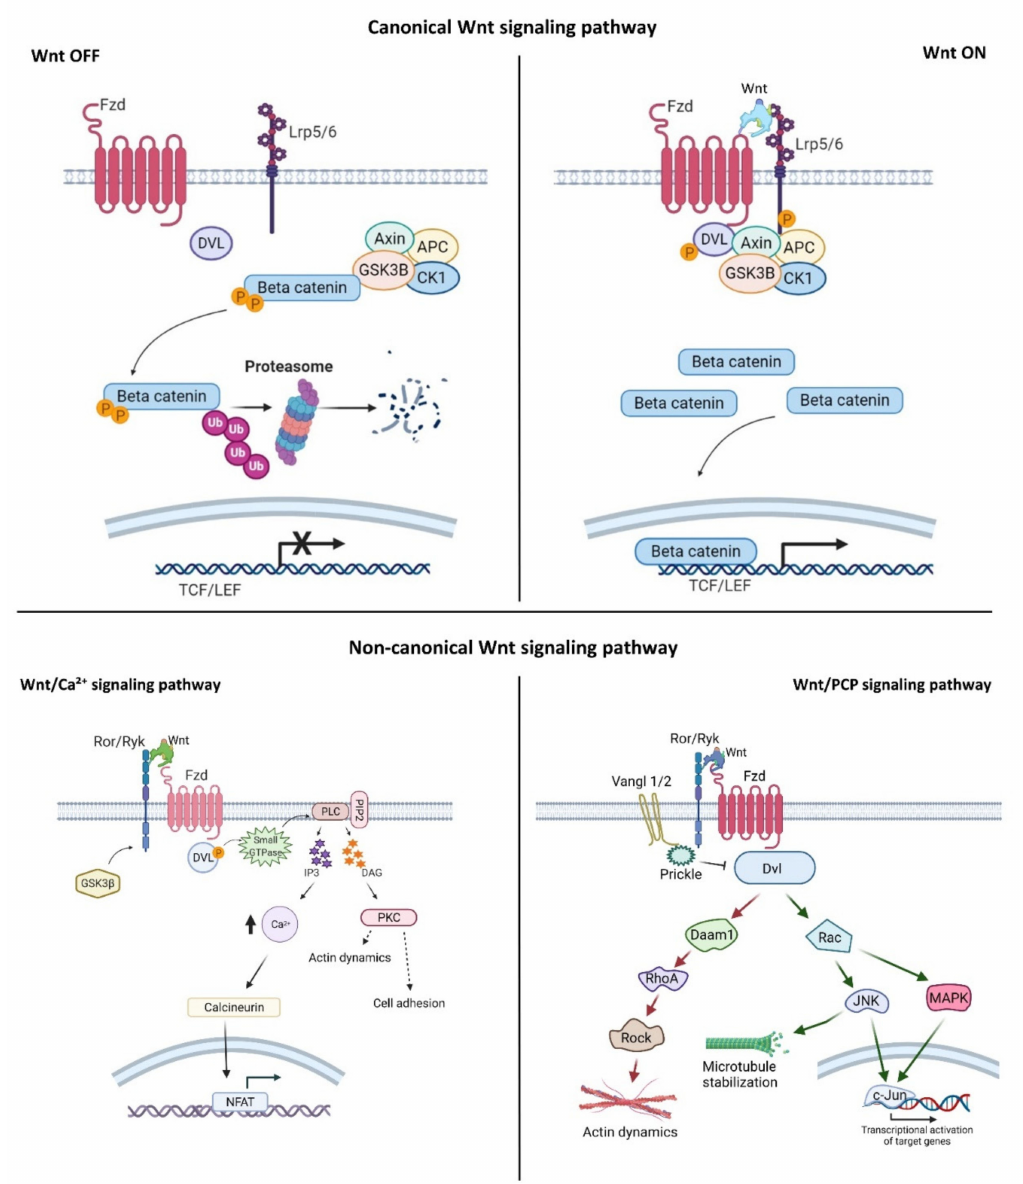
Figure 1. Wnt signaling pathway activation. The canonical Wnt signaling pathway: In the Wnt-off state, Gsk3 β , and Apc phosphorylate β -catenin and degrade it by ubiquitination. In the Wnt-on state, the canonical Wnt binds to Fzd receptors and Lrp5/6 co-receptors. This interaction recruits Dvl and Axin to the Wnt–receptor complex, and causes stabilization of β -catenin in the cytosol. Next, β -catenin is translocated into the nucleus, where it binds to the Tcf/Lef regions and activates Wnt target genes. Non-canonical Wnt signaling pathways: In the calcium pathway, binding of non-canonical Wnt ligands to Ror-Ryk-Fzd recruits Dvl which, in turn, binds to small GTPase to further activate phospholipase C (PLC). In the PCP pathway, non-canonical Wnt ligands bind to the Ror/Ryk-Fzd receptor complex, recruiting Dvl to the plasma membrane and activating Rac and Daam1. Next, target genes are transcriptionally activated through JNK and MAPK. Created with